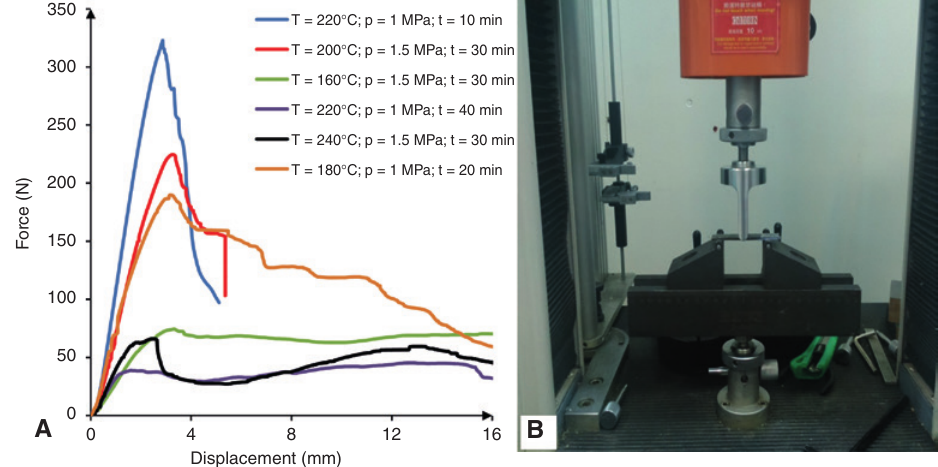
Figure 4: (A) Load-displacement curves of some samples, (B) the used three-point bending test setup.